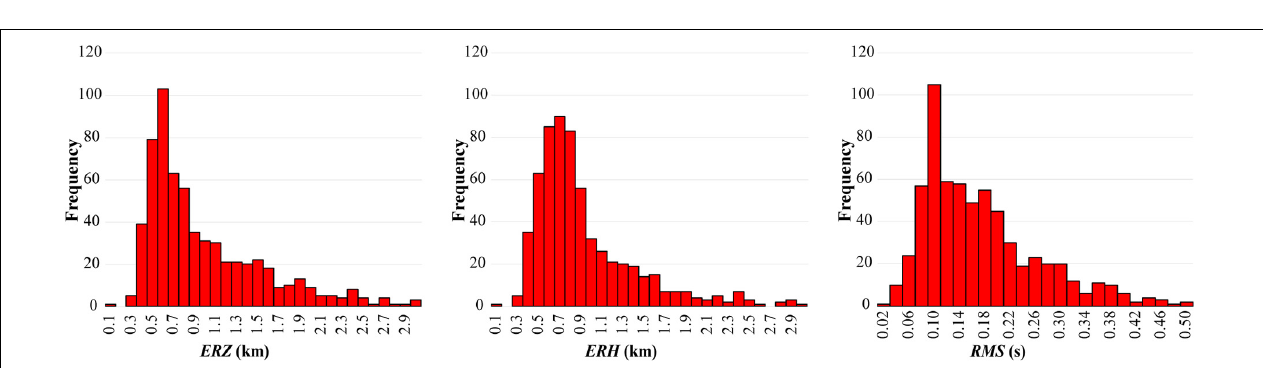
FIGURE 3 | Frequency histograms of the vertical ( ERZ ) and horizontal ( ERH ) localization errors and of the event RMS for all the 635 events recorded from April 2013 to June 2020.